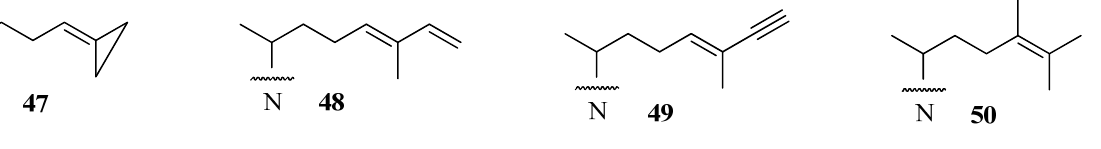
Figure 8. Side chain structures of substrate analogs that mimic Δ 24 -sterols